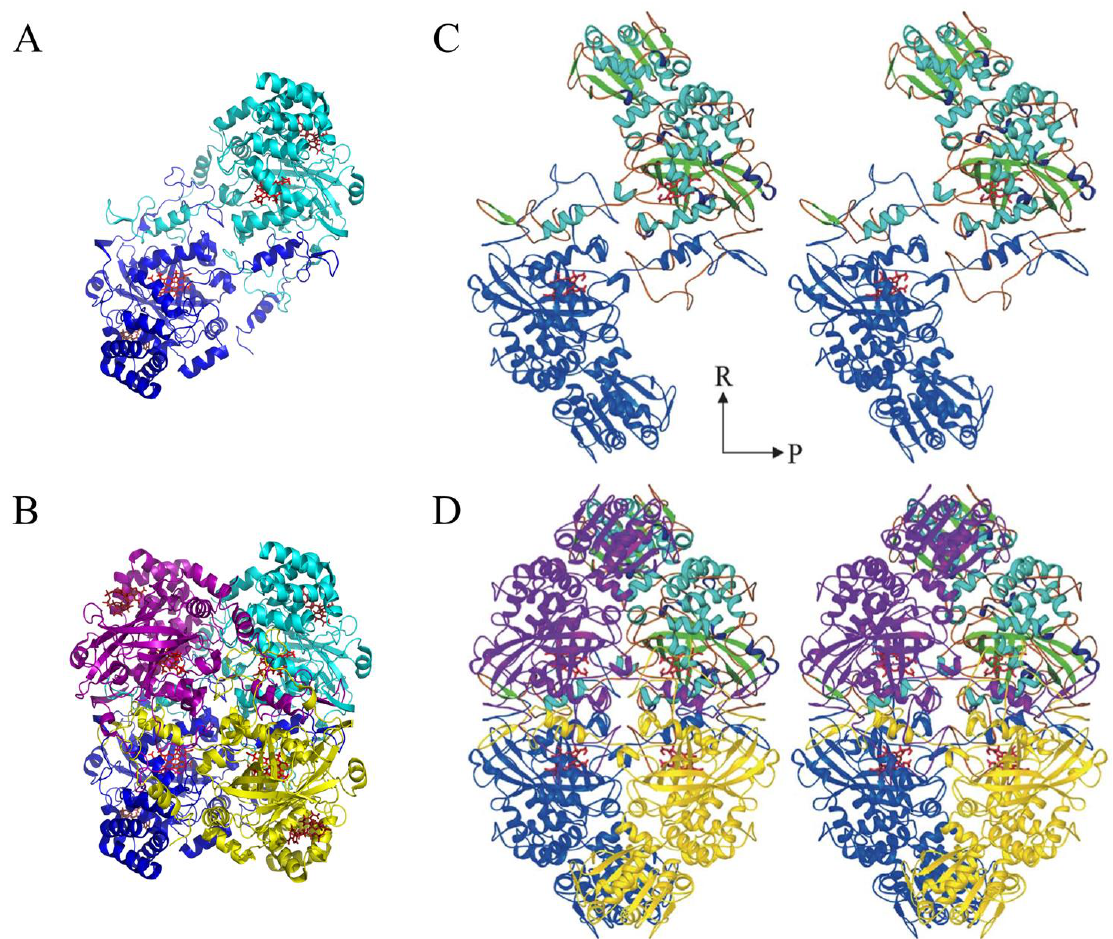
Figure 2. Dimer and tetramer of BLC and CAT-1. ( A ) dimer and ( B ) tetramer of BLC. ( C ) Stereo view of a CAT-1 dimer with Q related subunits. The N-terminal arm of each subunit hooks into the wrapping domain of the other subunit. ( D ) Stereo view of the CAT-1 tetramer. Figures ( C , D ) are reprinted with permission from ref. [41] 2004, Elsevier.